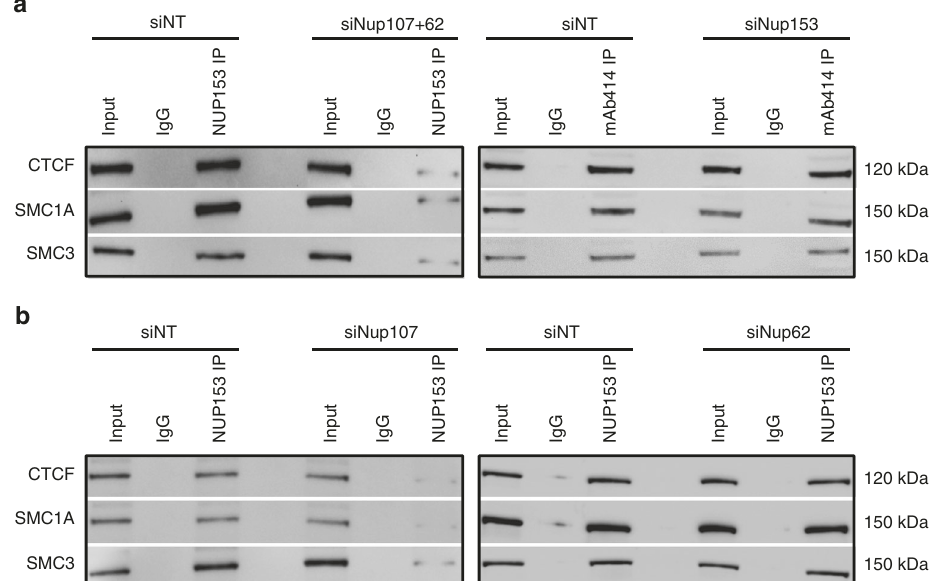
Fig. 8 NUP107 is required for NUP153 and NUP62 interaction with CTCF, SMC1A, and SMC3. a NUP-immunoprecipitation with NUP153 and mAb414 antibodies was performed on control (siNT) and Nup107 / 62- and Nup153 -depleted XEN nuclear lysates, following which western analysis was conducted using CTCF, SMC1A, and SMC3 antibodies ( n = 3 biological replicates). b NUP-immunoprecipitation with NUP153 antibodies was performed on Nup107- and Nup62 -depleted XEN lysates, followed by western analysis using CTCF, SMC1A, and SMC3 antibodies ( n = 3 biological